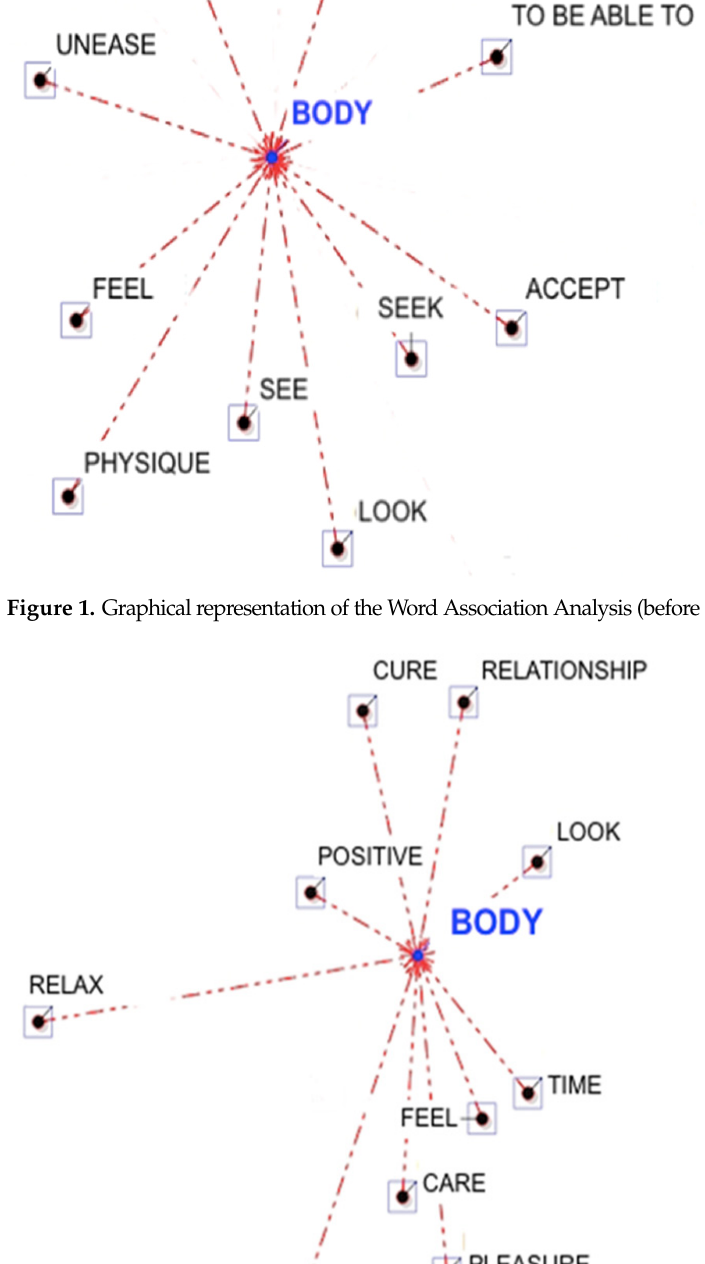
Figure 2. Graphical representation of the Word Association Analysis (after the psychological inter- vention).